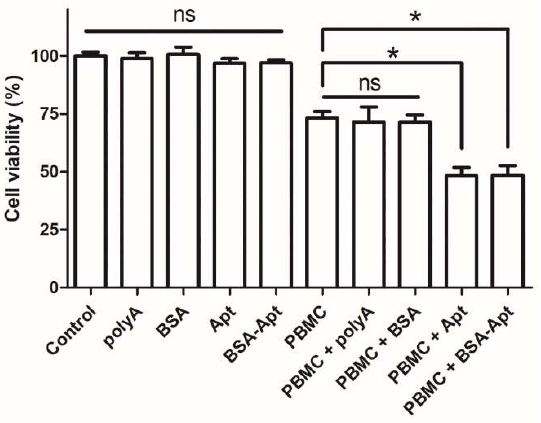
Figure 6. Immune cytotoxicity against PDL1-positive MDA-MB-231 cells in vitro. MDA-MB-231 cells were cultured in the presence or the absence of PBMC. The cells were treated with polyA, BSA, PD-L1 aptamer, or BSA-Apt. The PBMC was subsequently washed off and tumor cells were evaluated for viability with standard MTS assay ( n = 6). Single star indicates statistically significant differences ( p < 0.05), and “ns” indicates no significance.